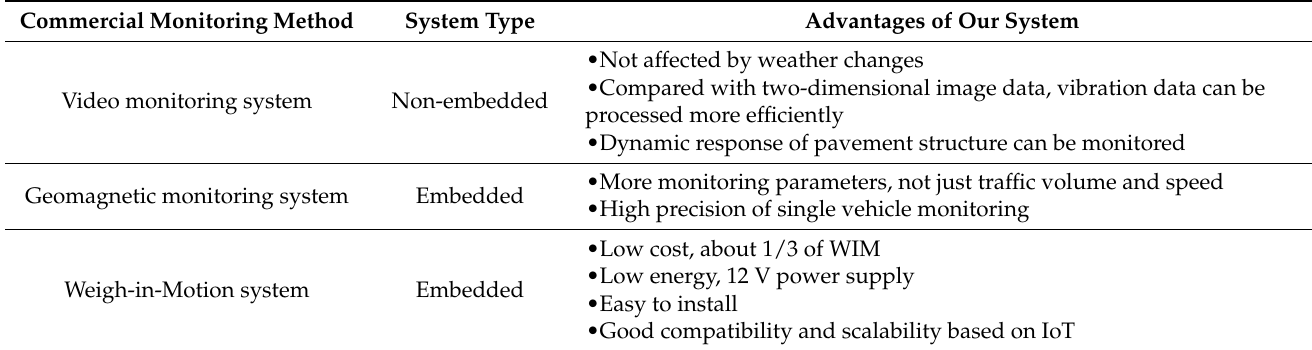
Table 1. Advantage of the developed pavement vibration Internet of Things (IoT) monitoring